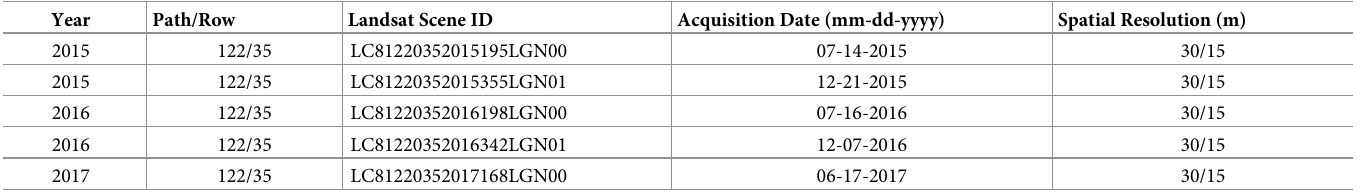
Table 1. Metadata of Landsat-8 OLI images covering the study region. The spatial resolutions of images were 30 m for multi-spectral bands and 15 m for the panorama band.